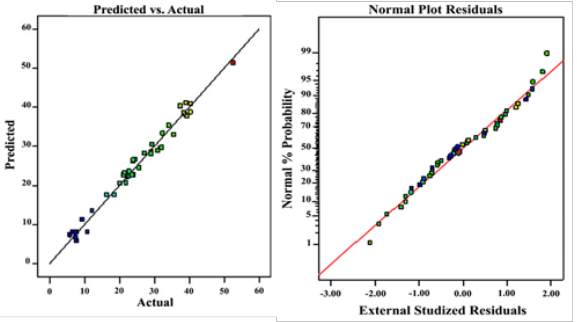
Fig. 3. Predicted vs. actual response and normal plot of